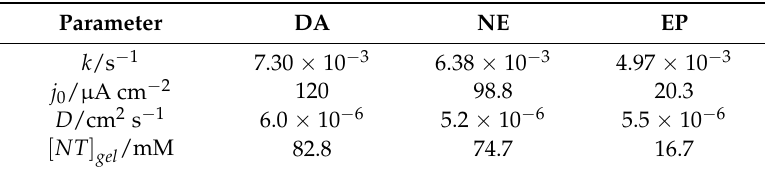
Figure 6. ( A ) Peak current density for catecholamine neurotransmitters (NT) oxidation in blank PBS solution after equilibration in 1 mM NT solution. Symbols denote experimental data, while the solid curves have been obtained by fitting a first-order decay and ( B ) logarithmic time dependence of the oxidation peak current density for each NT. Table 1. Pseudo first-order rate constants for the desorption of neurotransmitters, initial anodic peak current density, diffusion coefficient [34] and apparent concentration of adsorbed neurotransmitters obtained from Equation 4.